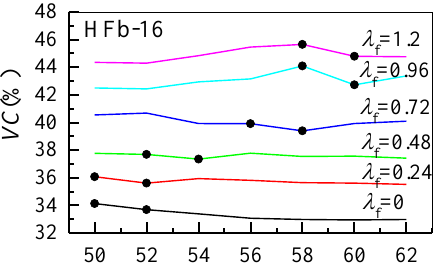
Figure 5. The deterministic process for optimal sand ratios for HFb-16.